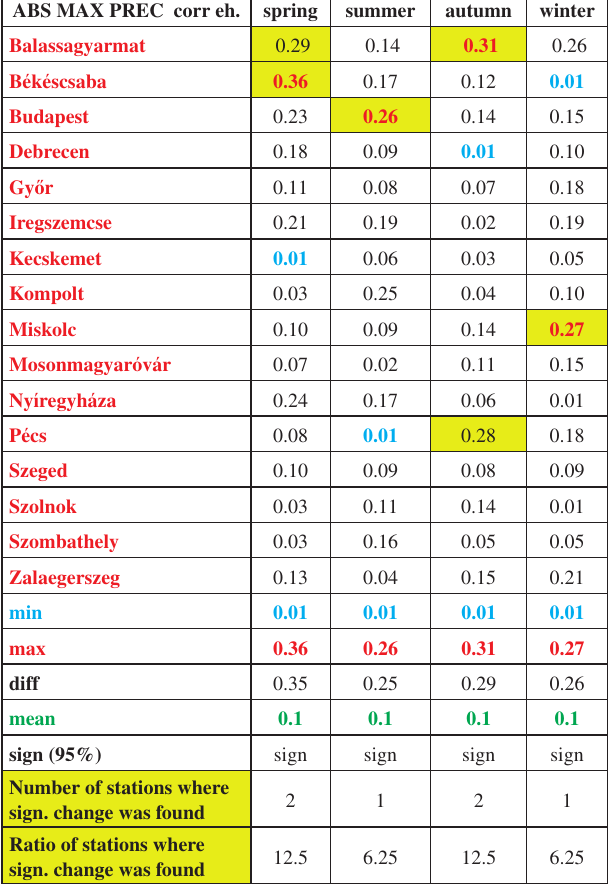
Table 3 – Coeffi cient of correlation between the fi tted function of the trend and the measured data of absolute daily maxima of precipitation measured at 16 stations during the four seasons over a period of 1951–2010 ABS MAX PREC corr eh.